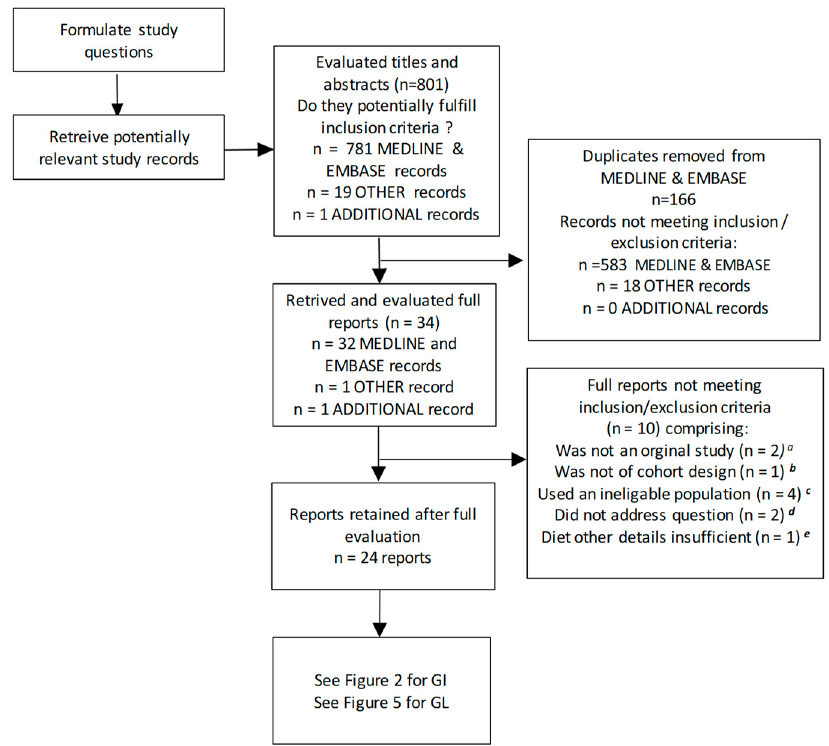
Figure 1. Process of the review and outcomes of the inclusion / exclusion criteria for the T2D–GI and GL risk relations. The literature was searched for prospective cohort studies investigating these relations, from 1946 to 6 December 2018. MEDLINE, EMBASE, and other sources (see Methods) were searched. a – e : See Section 3 of the Supplementary Materials for further details. Abbreviations: GI, glycemic index; n, number of published reports; T2D, type 2 diabetes; GL, glycemic load.